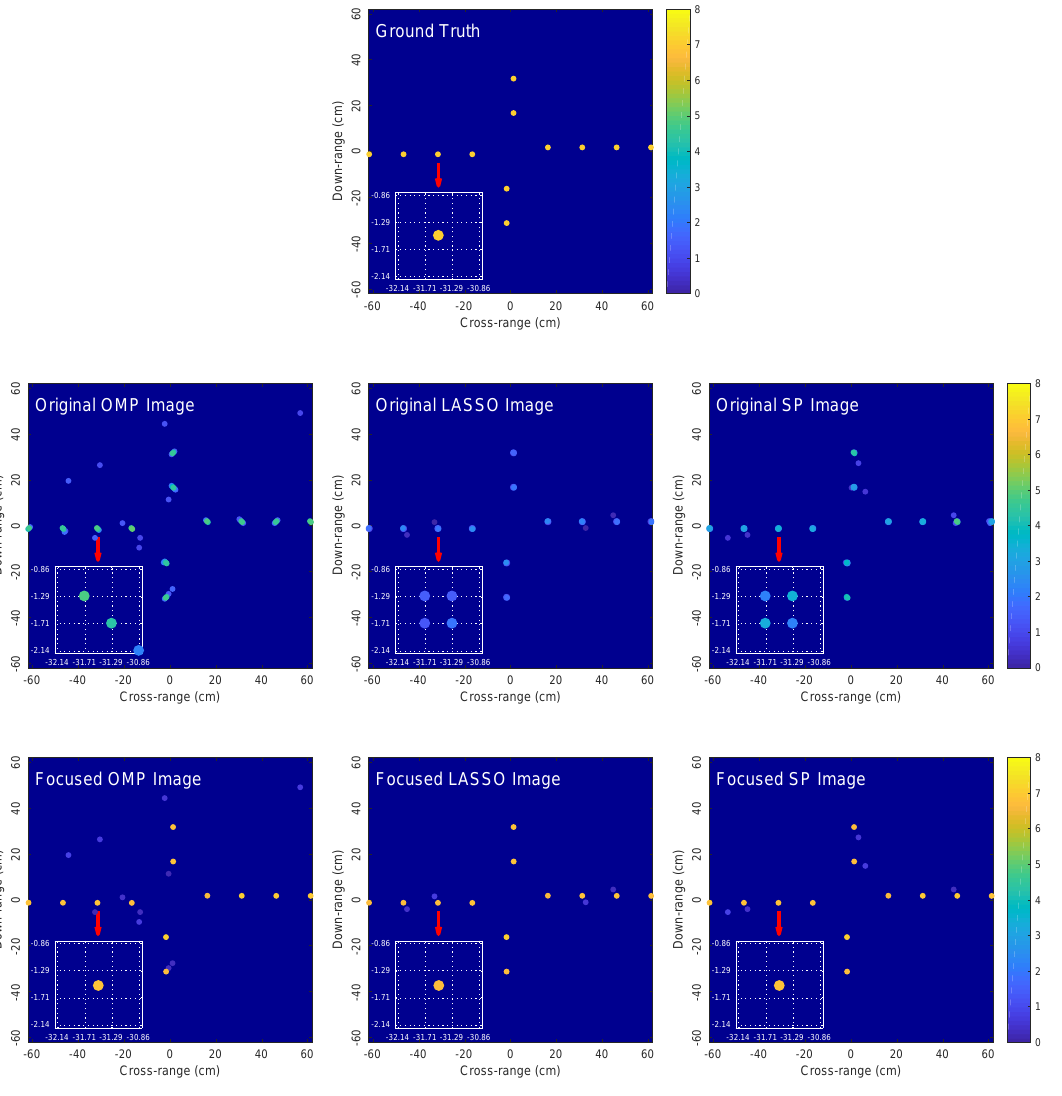
Figure 7. Comparison of the original OMP, LASSO and SP images and the corresponding focused images obtained by the proposed algorithm for Target 2. In the zoomed-in images, dictionary grid points are located at intersections of dotted